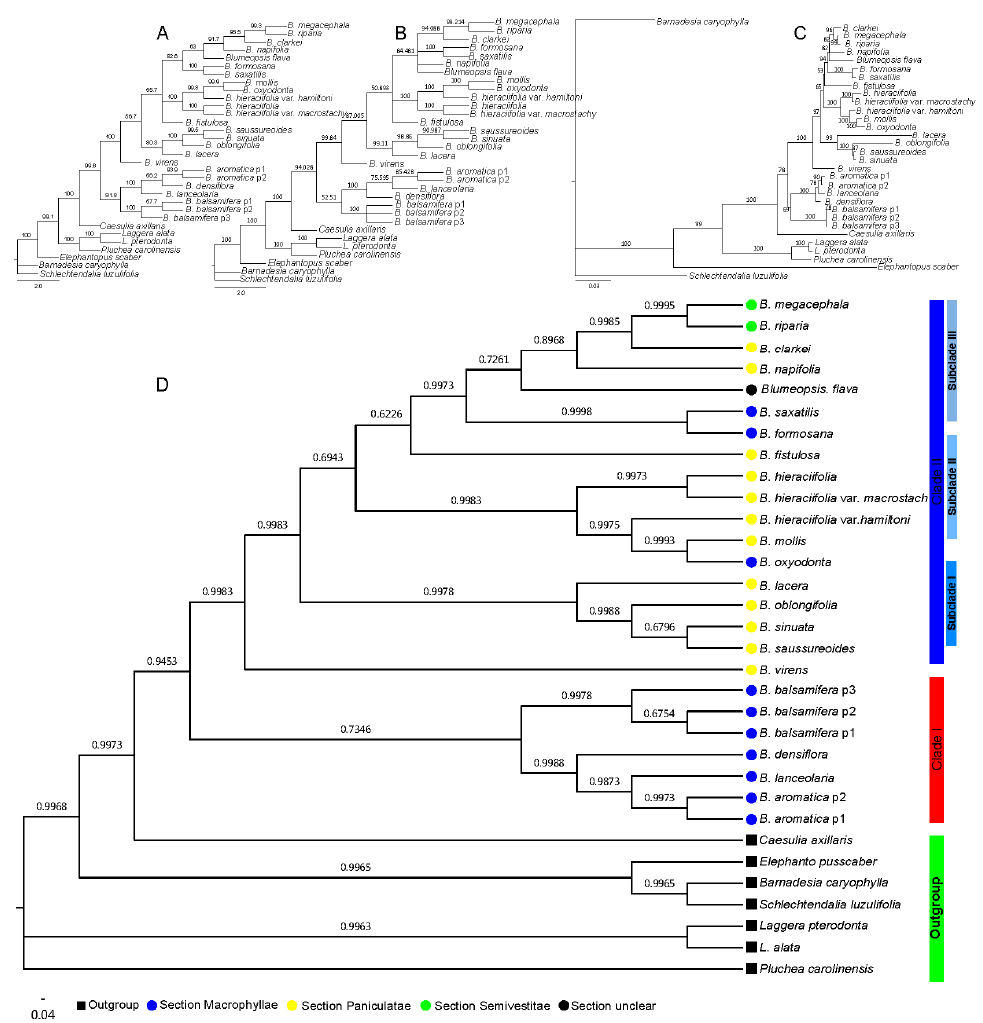
Figure 3. Phylogenetic tree based on the combined sequence; the numbers above the branches indicate the bootstrap value or posterior probabilities. The numbers above the branches indicate the bootstrap value. ( A ) Phylogenetic tree determined by the neighbor-joining (NJ) method using the PAUP program, ( B ) phylogenetic tree determined by the MP method using the PAUP program, ( C ) phylogenetic tree determined by the ML method using the IQtree program, and ( D ) phylogenetic tree determined by the BI method using the MrBayes program.